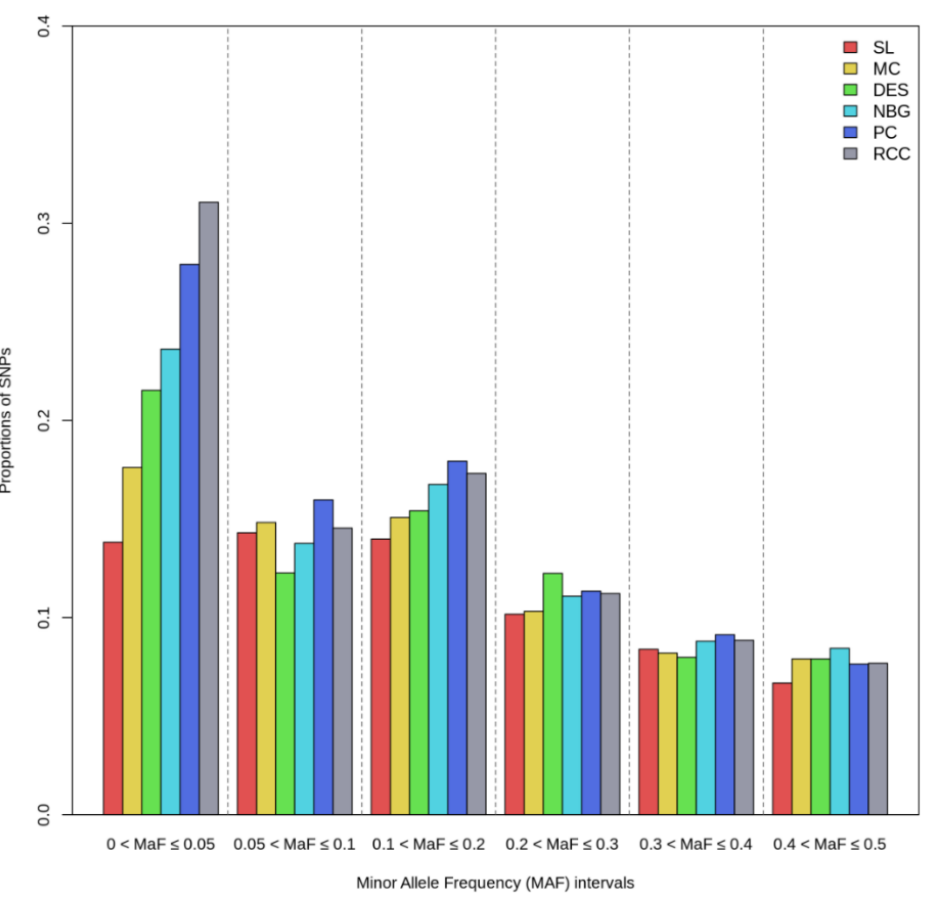
Figure 1. Minor allele frequency distribution across six Bangladeshi indigenous cattle populations. The included populations are Sahiwal (SL), Munshiganj (MC), Non-descript Deshi (DES), North Bengal Grey (NBG), Pabna (PC), and Red Chittagong (RCC).